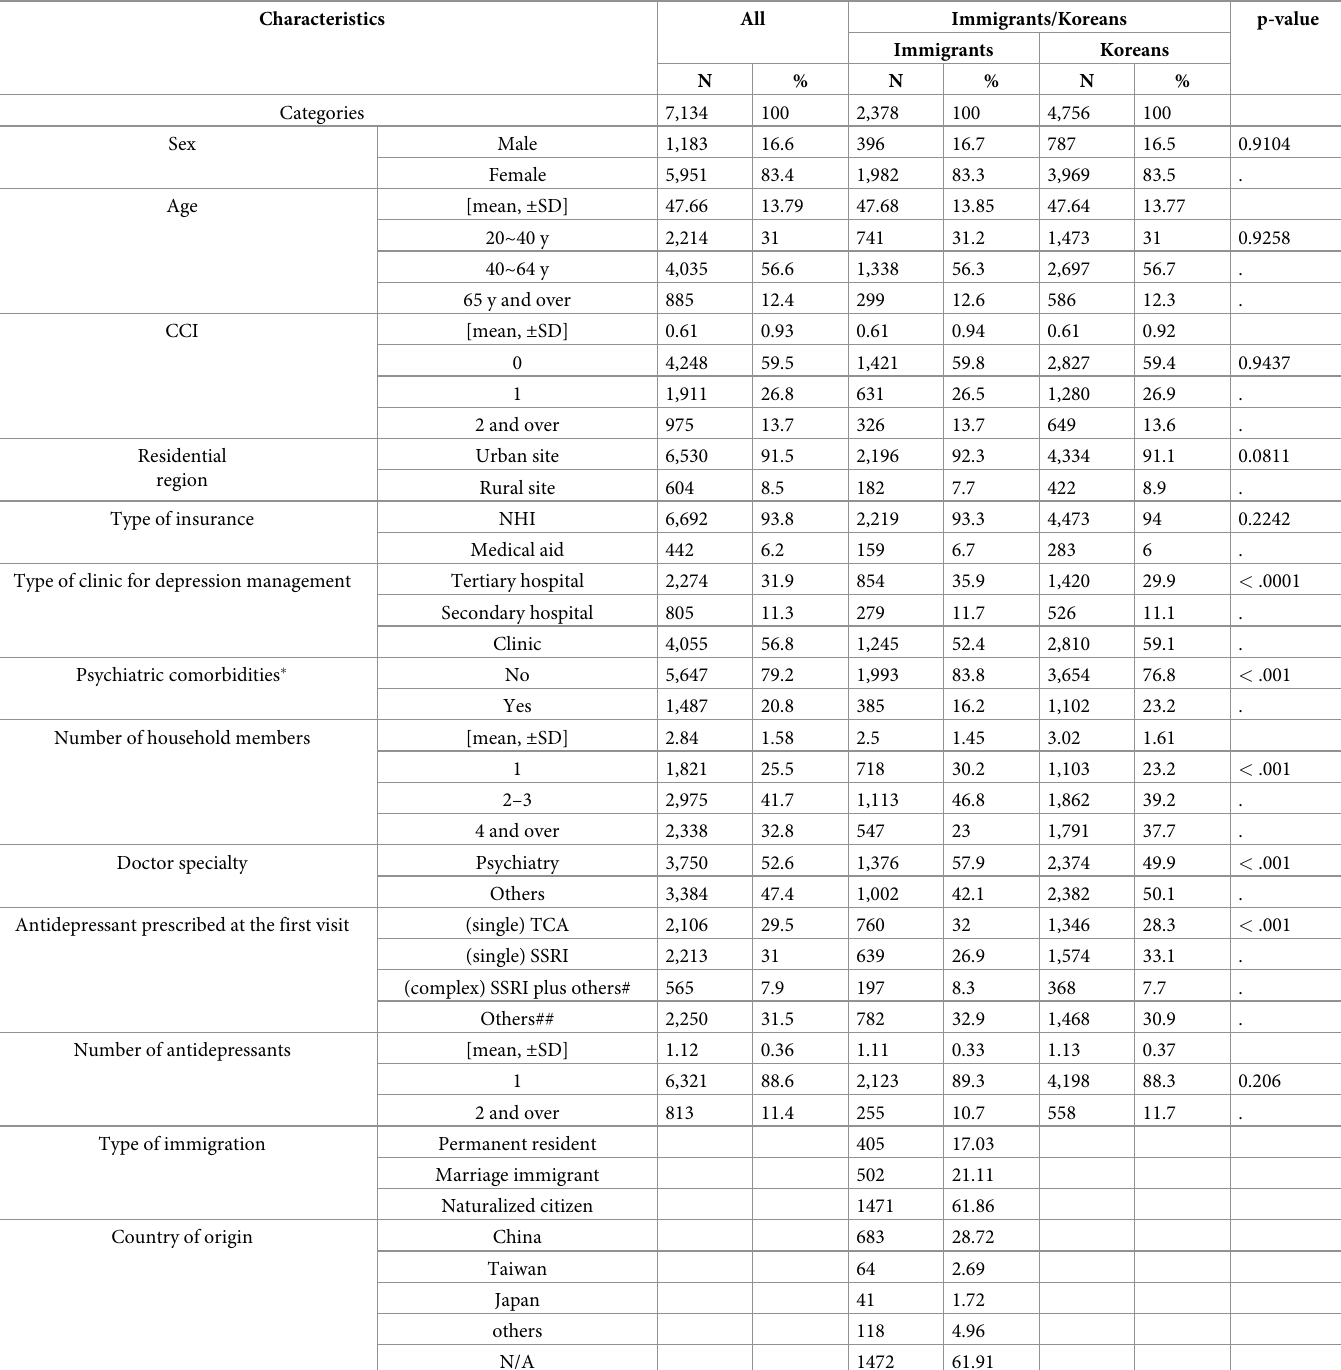
Table 1. Characteristics of immigrants and native Koreans with depression.